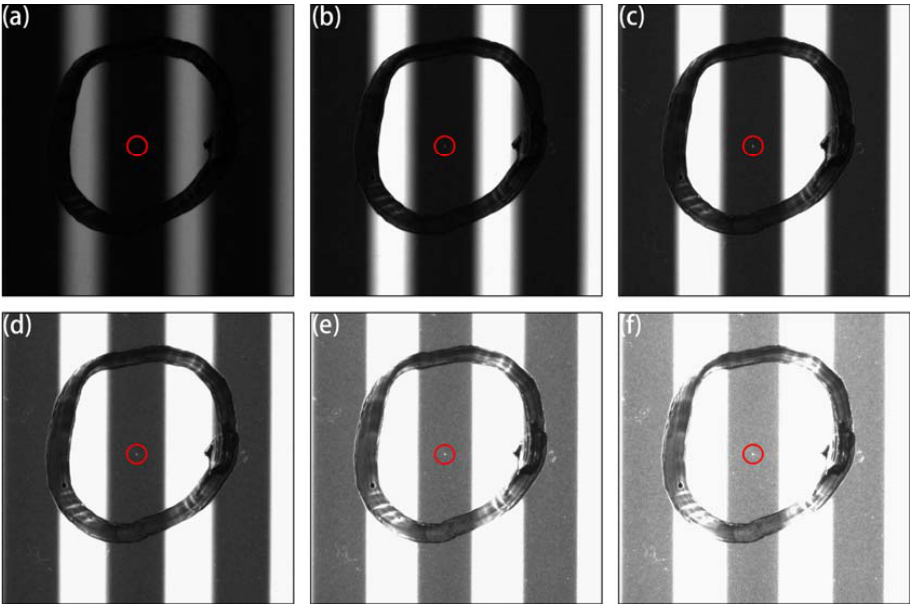
Figure 4. Indentation defect images with various exposure times: ( a – f ) 10, 30, 60, 100, 200, and 300 ms; object distance, 40 mm; image distance, 71.9 mm; camera gain, 4.25×.